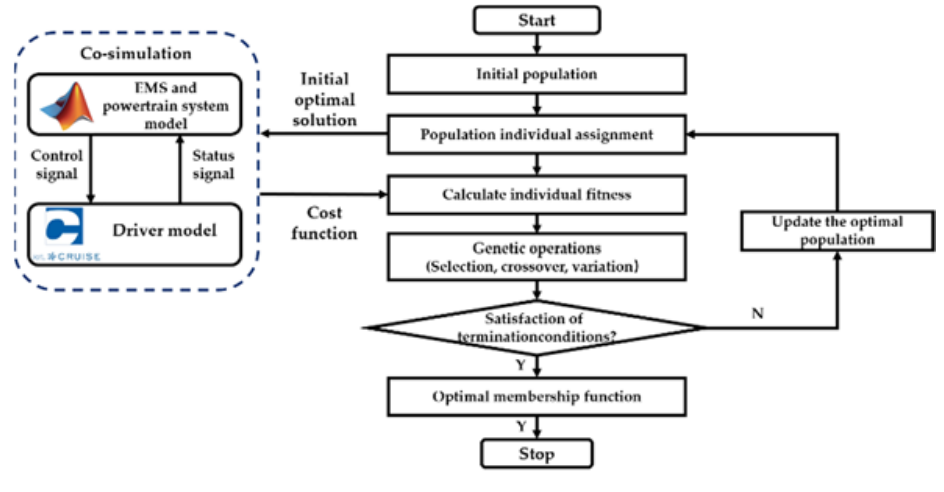
Figure 8. Genetic algorithm optimization process.